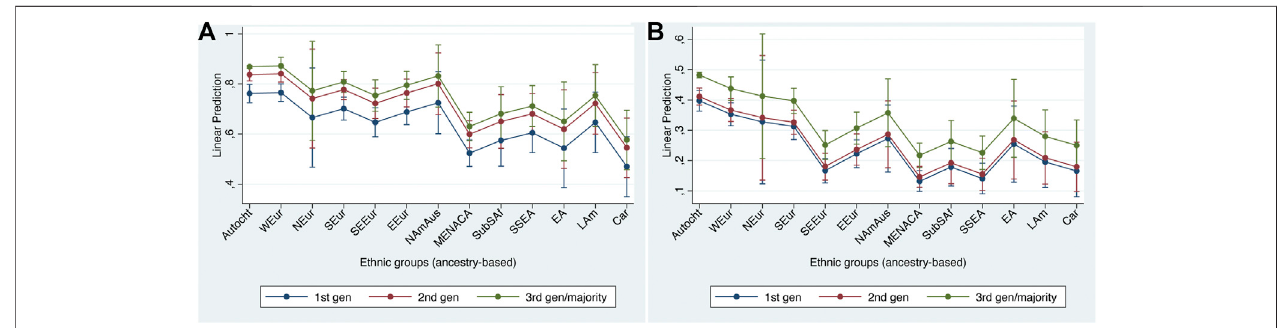
FIGURE 3 | Adjusted predictions at representative values for social integration indicators with 95% con fi dence intervals (main effects models). (A) no or some minority ethnic minority people in living area; (B) no ethnic minority